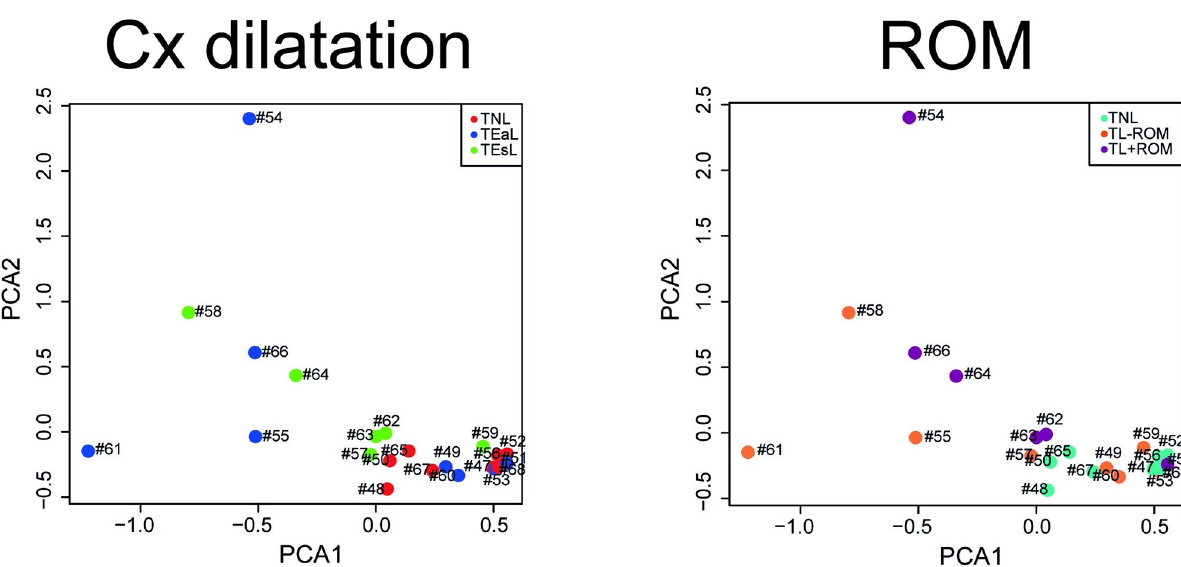
Fig 1. PCA for RNA-seq of myometrium biopsies from term pregnant women at different stages of labour. Summary by principal component analysis (PCA) of overall differences in transcriptome profiles from human myometrium biopsies obtained from term gestation singleton pregnant women, which were grouped by status of cervical (Cx) dilatation or fetal membrane rupture (ROM; > 1 hour prior to fetal delivery) at time of Caesarean section; sample identification numbers are shown next to their respective data points. For Cx dilatation, labouring women were grouped as either in early ( � 3 cm; TEaL, n = 8) or established ( > 3 cm; TEsL, n = 6) labour. For ROM, women were grouped as either labouring in the absence (TL-ROM, n = 8) or presence (TL+ROM, n = 6) of ROM. The non-labouring (TNL, n = 8) group was the same for both sets of comparisons.